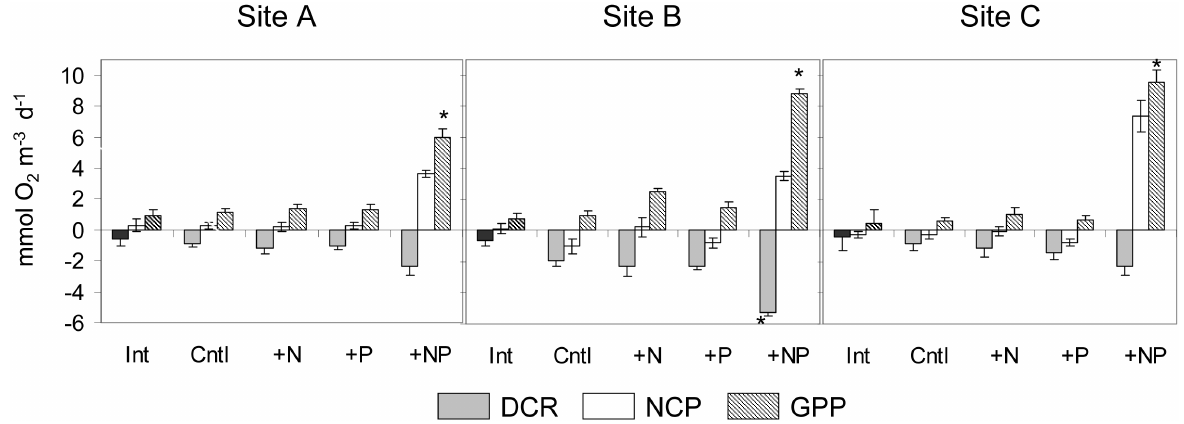
Fig. 2. Gross primary production (GPP), dark community respiration (DCR) and net community production (NCP) initial (Int) and at the end of the experiment in the Control (Cntl), the nitrogen (+N), phosphorus (+P) and nitrogen and phosphorus (+NP) additions. * denotes significant difference with the Control.